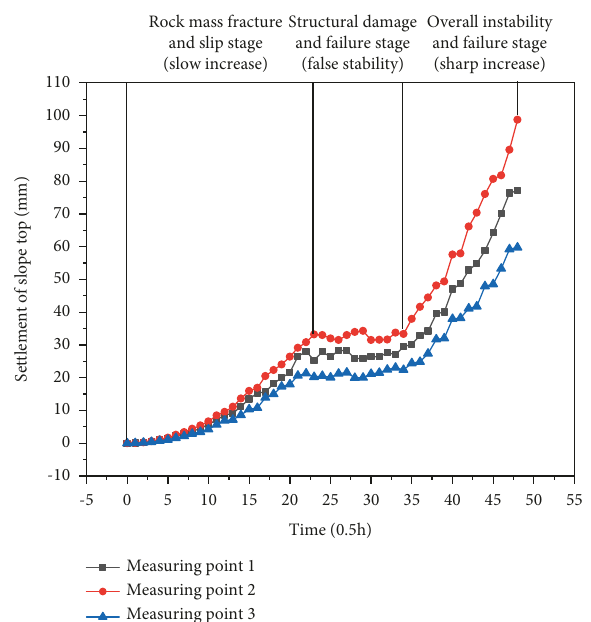
Figure 21: Observation of surface settlement deformation of tunnel portal slope.